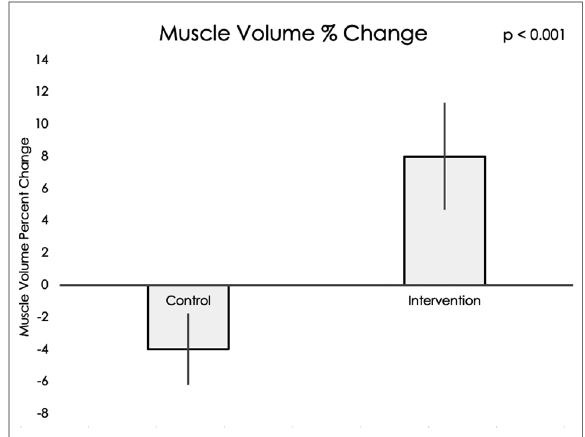
FIGURE 5 Using a Wilcoxon rank sum test, a signi fi cant difference was found in